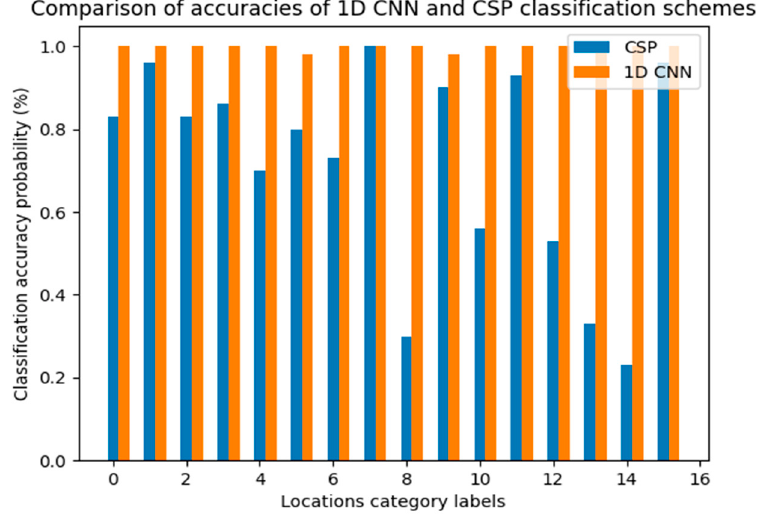
Figure 13. Comparison of classification accuracies of 1D CNN model and CSP algorithm.